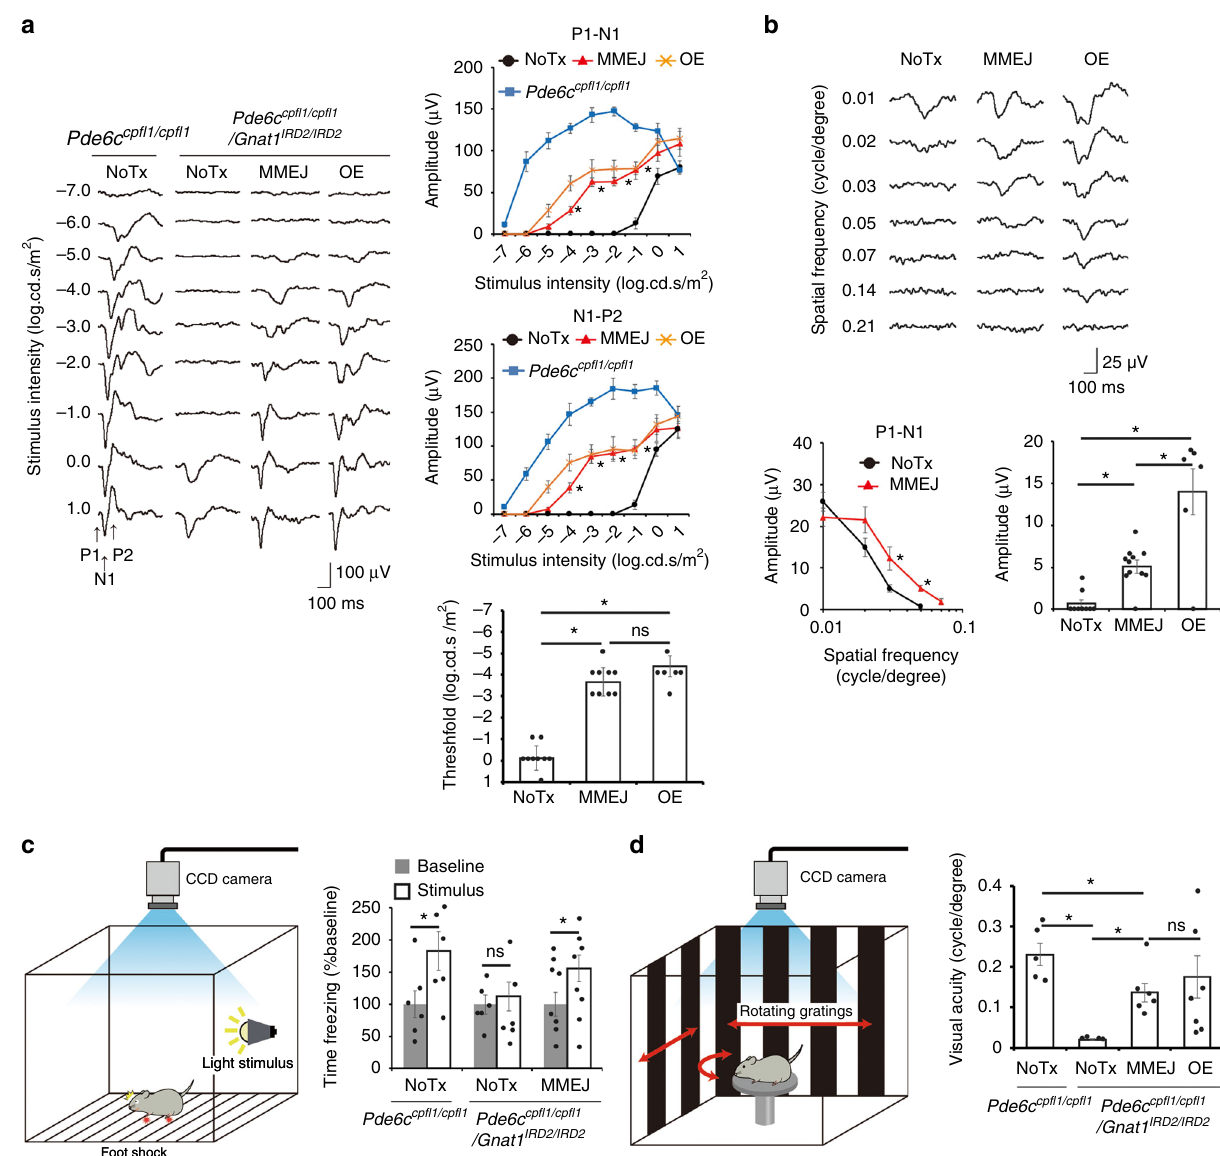
Fig. 3 Visual restoration by in vivo mutation-replacement genome editing. Flash visually evoked potentials (fVEP) of the visual cortex contralateral to the eyes in response to fl ashes of various intensities. MMEJ indicates eyes treated with Gnat1 mutation replacement ( N = 9) and OE (over-expression) indicates those with Gnat1 gene supplementation ( N = 6), both delivered by single AAV. NoTx refers to untreated eyes ( N = 9). Control Pde6c cp fl 1/cp fl 1 mice ( N = 5). Note, light sensitivity as de fi ned in the Methods was increased by ~4 log unit after MMEJ-mediated genome editing, which was not signi fi cantly different to the effect mediated by OE (right lower panel). b Pattern VEPs. N = 11, 10, and 6 for MMEJ, untreated and OE, respectively. c Fear conditioning test. Freezing time before (Baseline) and during (Stimulus) presentation of fear-conditioned light cue from MMEJ treated ( N = 9) and untreated ( N = 6) mice. d Optokinetic response. Note threshold of spatial resolution of vision (visual acuity) was not different in the MMEJ and OE. N = 10, 7, and 4 for MMEJ, OE, and NoTx, respectively. Control Pde6c cp fl 1/cp fl 1 mice ( N = 6). Data represent the mean ± S.E.M.; * P < 0.05 ( a , b , d , ANOVAs followed by Tukey ’ s post hoc test; c Student ’ s t -test); nd, non-detectable; ns, not signi fi cant. Source data are provided as a Source Data fi